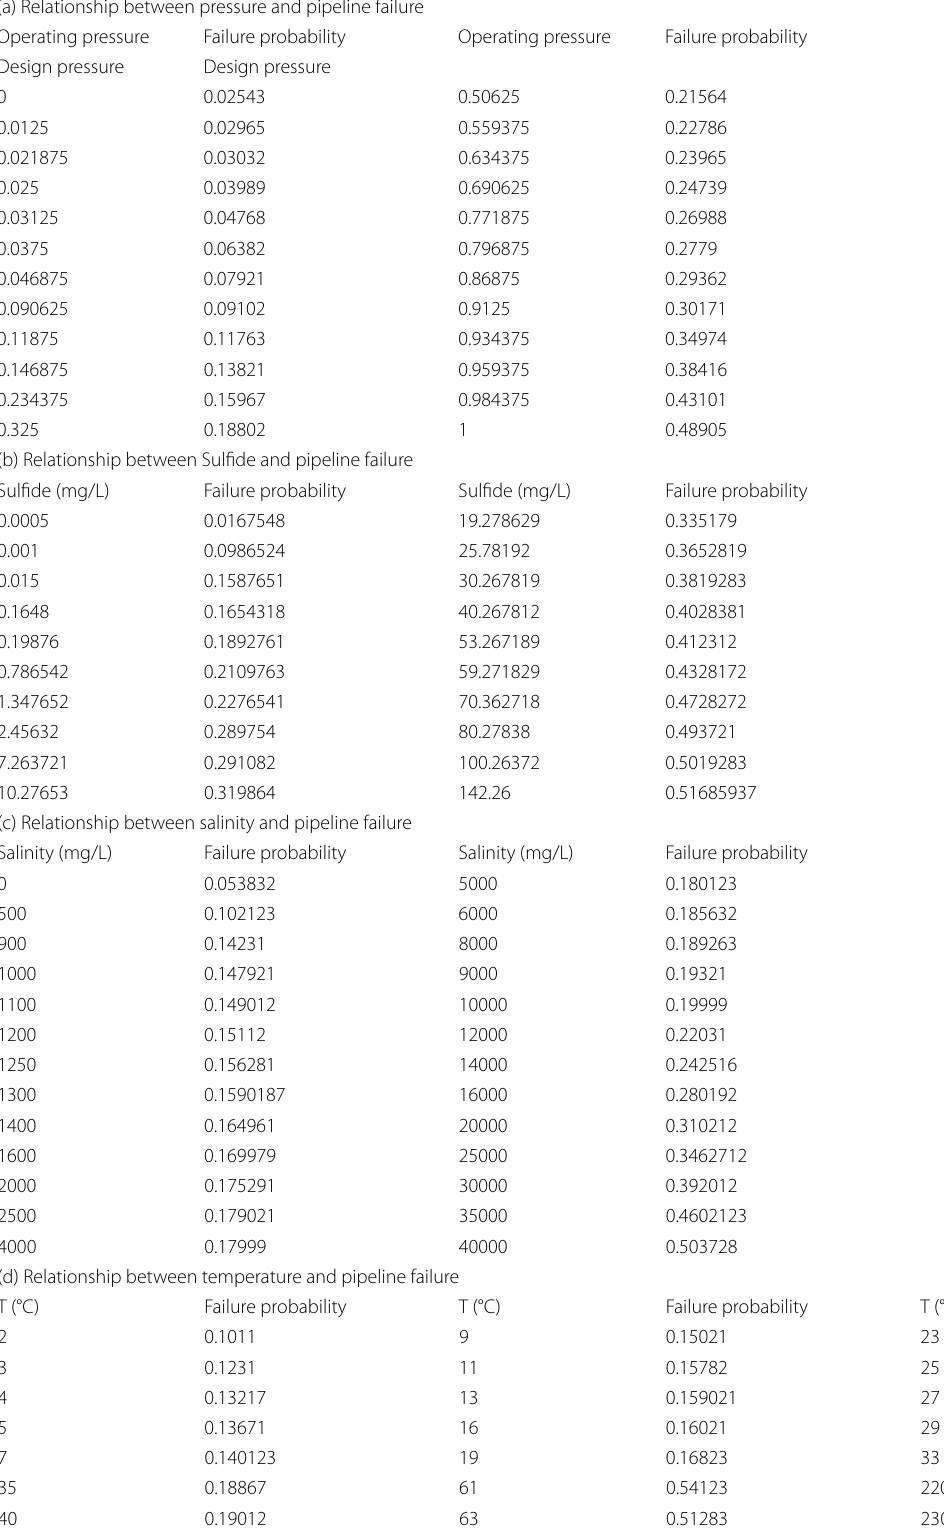
Table 1 Pipeline failure